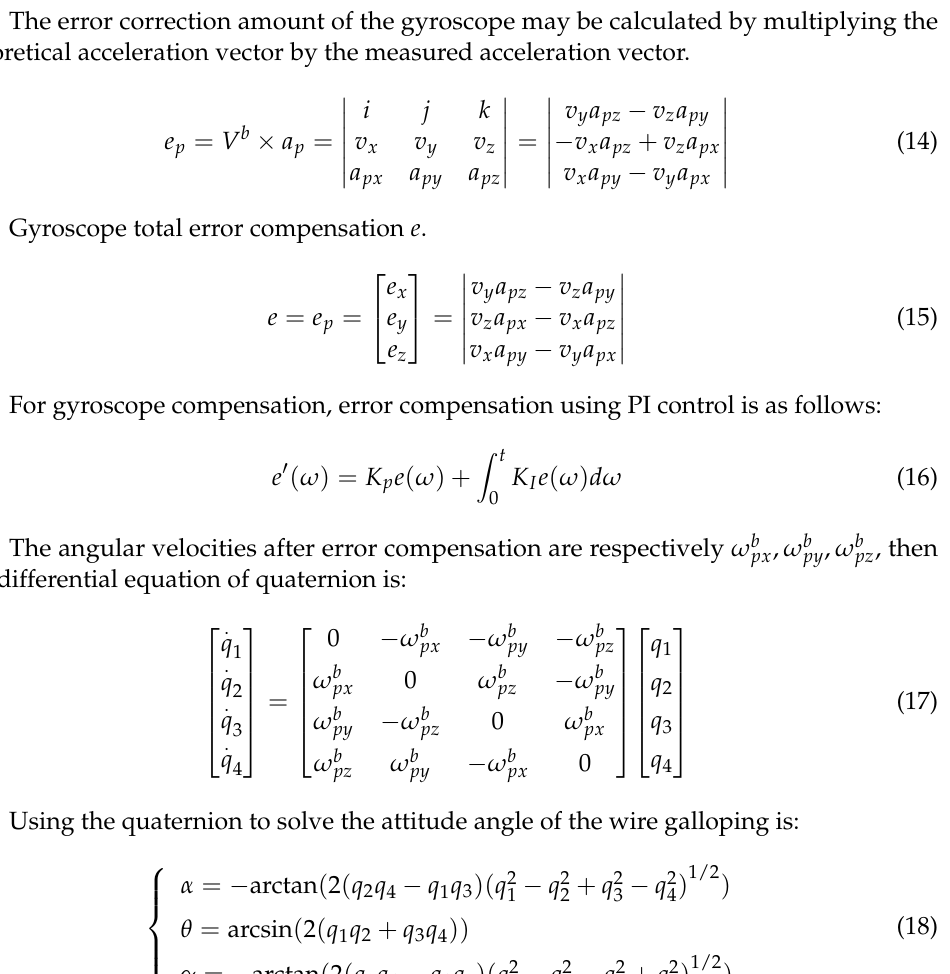
The combined algorithm of Kalman filtering and Mahony complementary